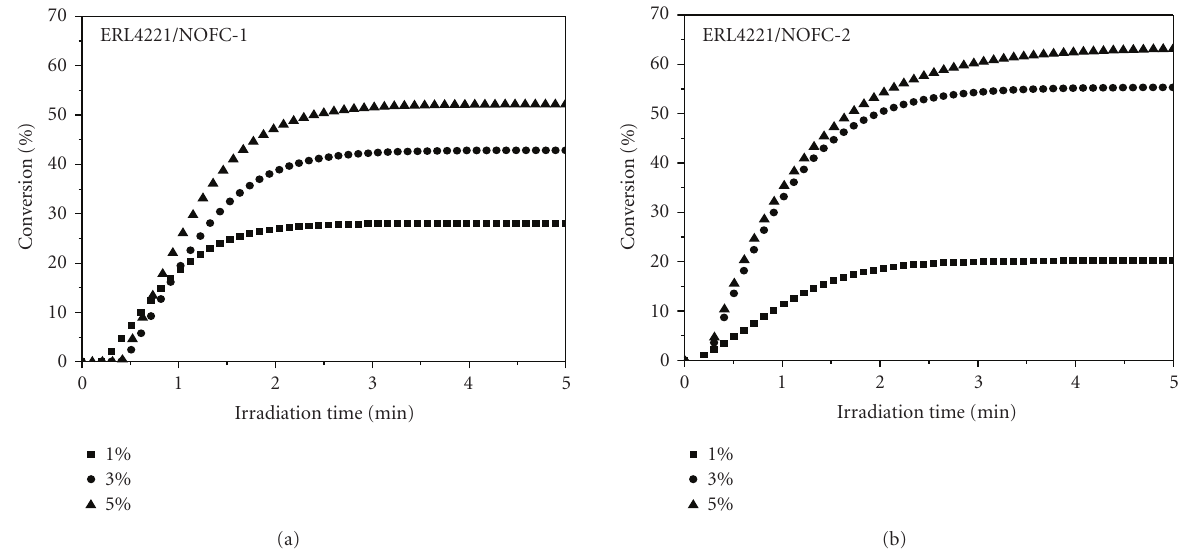
Figure 4: E ff ect of NOFC-1 and NOFC-2 concentration on the polymerization of ERL4221 (I = 80mW/cm 2